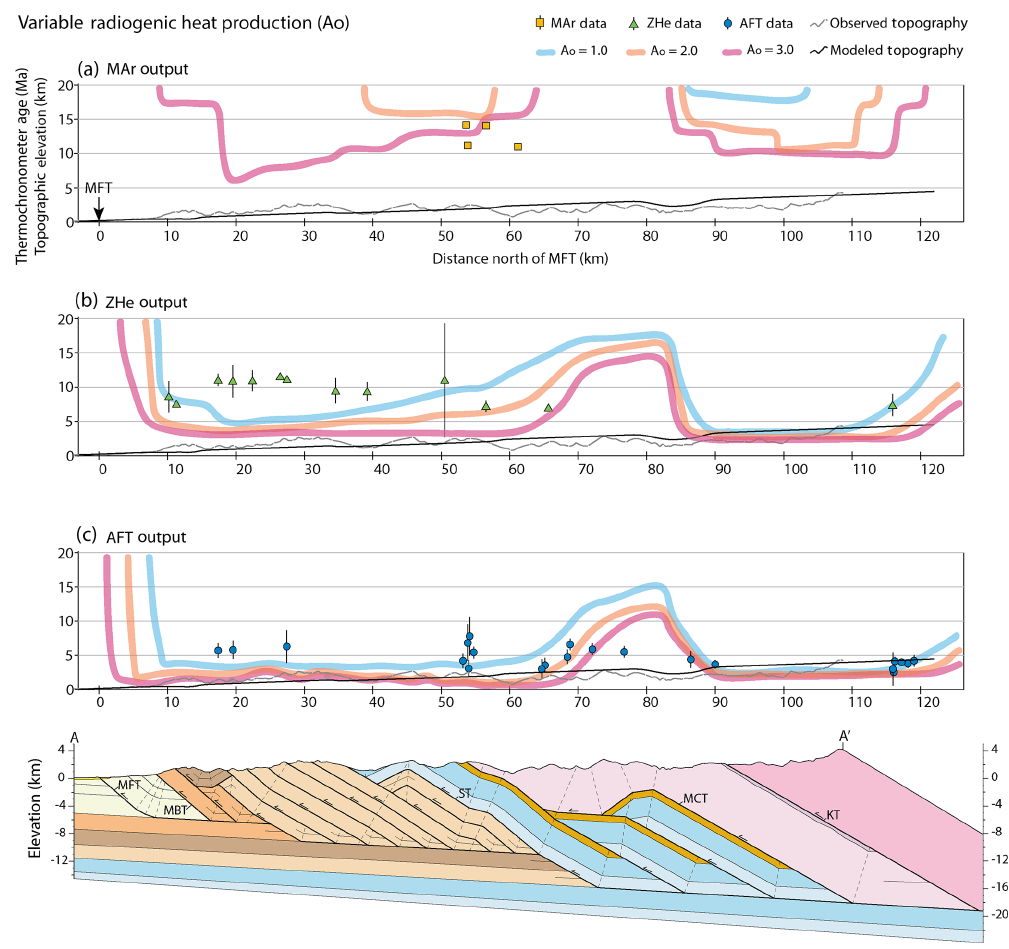
Figure 5. Predicted (a) MAr, (b) ZHe, and (c) AFT cooling ages from Pecube using variable surface radiogenic heat production ( A 0 ) values of 1.0 (blue), 2.0 (orange), and 3.0 (red) µWm − 3 compared to published cooling data. Other model variables are set as constant velocity, Split KT, and responsive